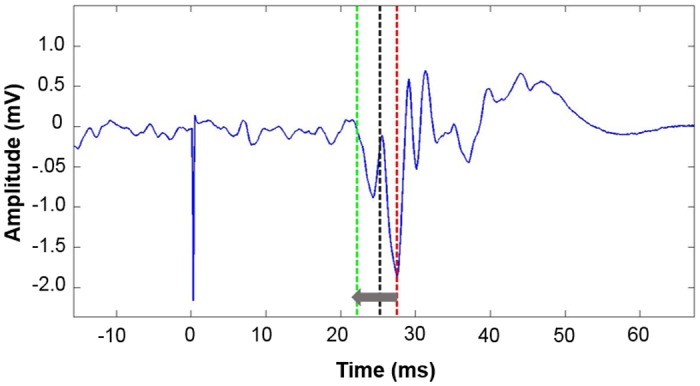
Windowed signal of a single trial.Black: 25 ms past TMS artifact, Red: MEP minimum, Green: CSP onset. mV = millivolt, ms = milliseconds.